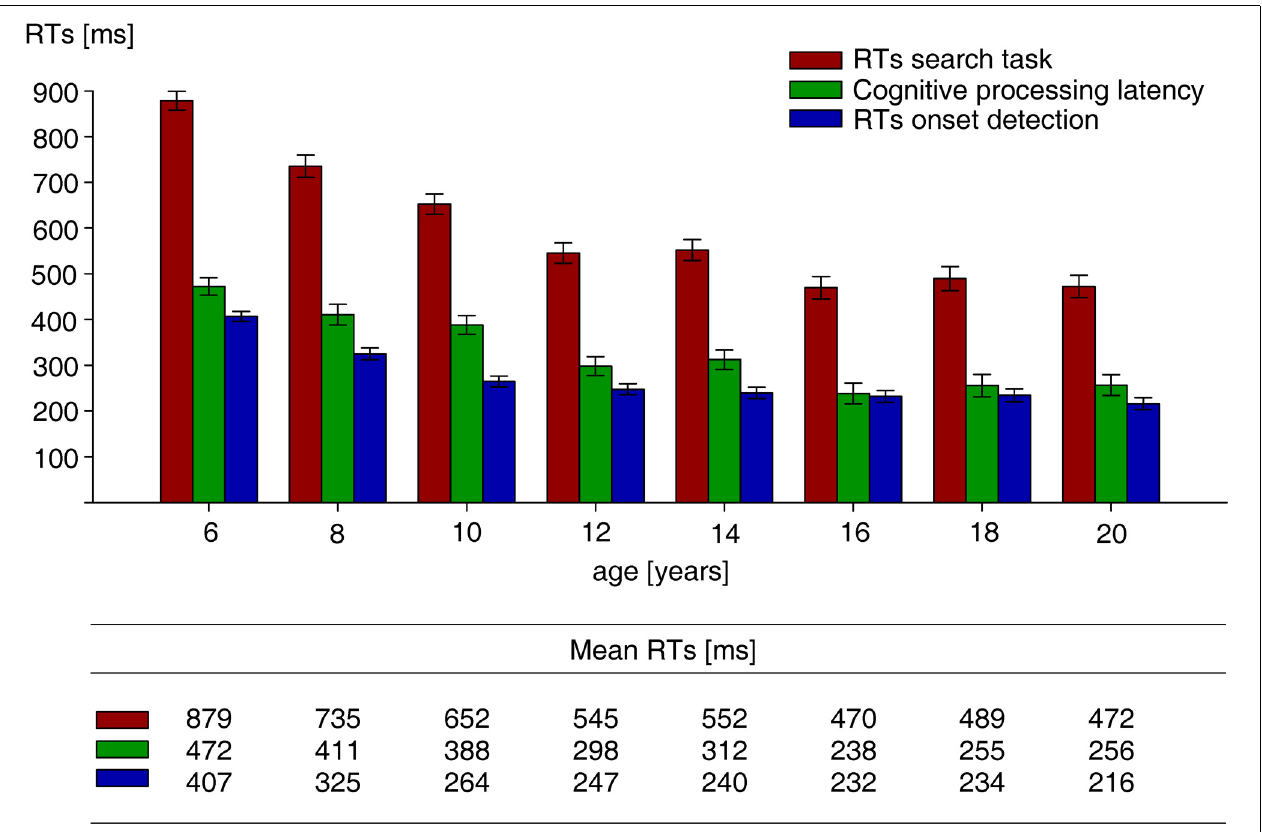
FIGURE 2 | Mean search RTs on target-present trials of the visual search task, mean RTs of the onset detection task, and mean cognitive processing latencies (obtained by subtracting RTs of the